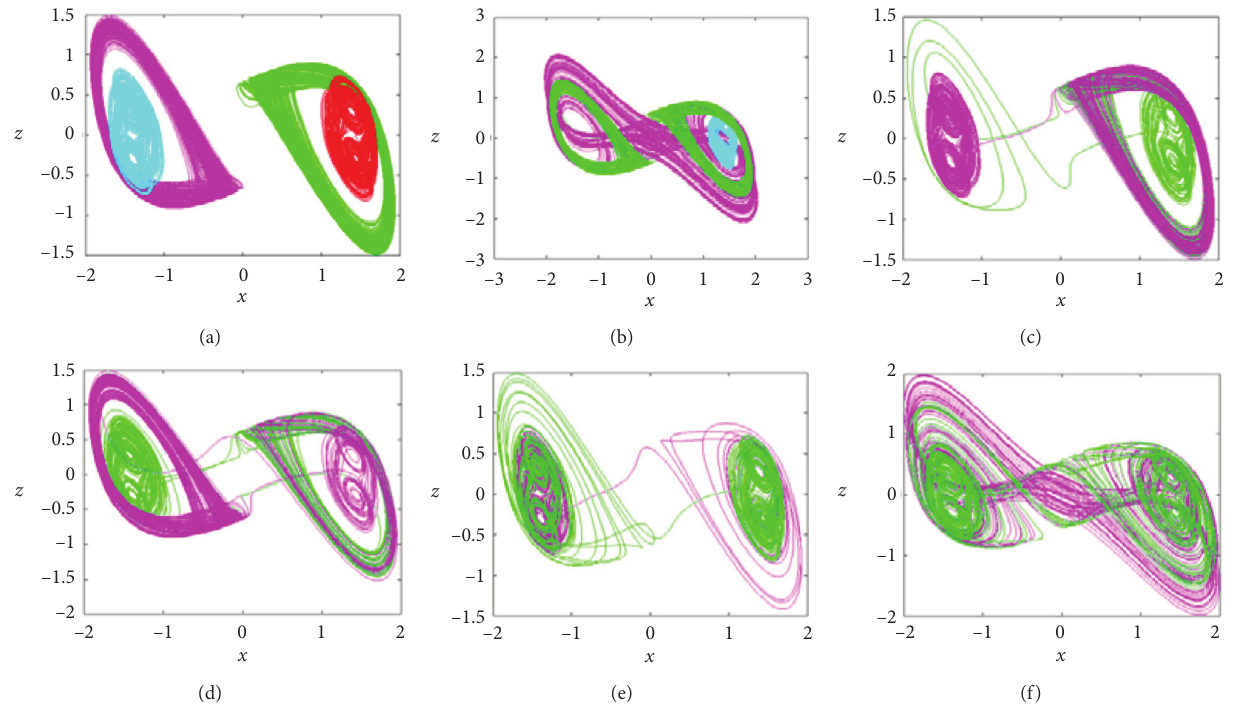
Figure 7: The coexistence of infinite number of attractors on x – z plane with different initial condition u (0).